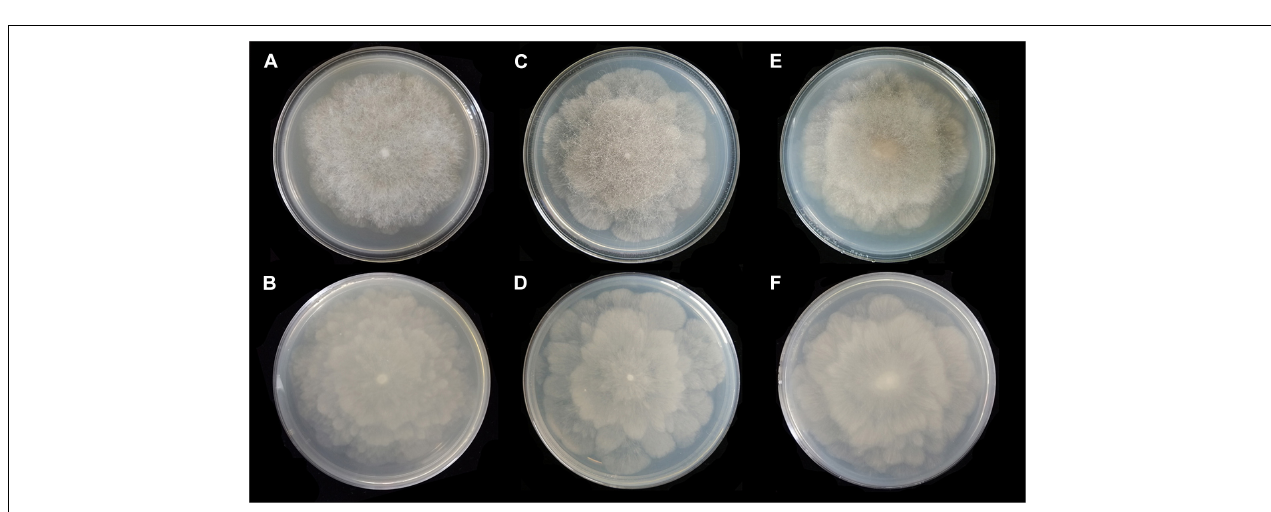
FIGURE 4 | Colonies of Absidia globospora CGMCC 3.16031 at 27 ◦ C after 6 days on MEA (A) obverse, (B) reverse; on SMA (C) obverse, (D) reverse; on PDA (E) obverse, and (F) reverse.